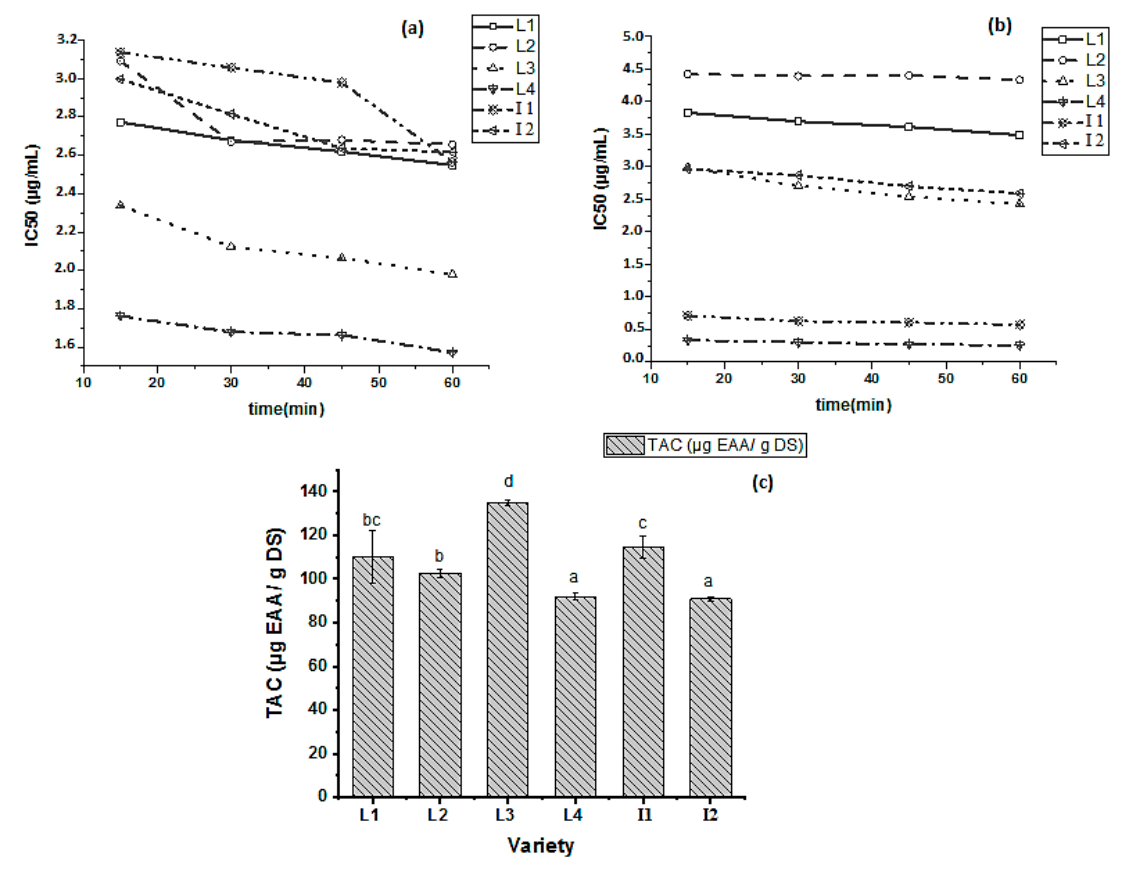
Figure 4. Antioxidant capacity of L1, L2, L3, L4, I1, and I2 varieties by DPPH • method (expressed as IC 50 μ g/mL) ( a ), ABTS •+ method (expressed as IC 50 μ g/mL) ( b ), and total antioxidant capacity (TAC) method (expressed as μ g eq ascorbic acid/g dry sample) ( c ). Table 7. Correlation matrix between phenolics contents and antioxidant activity of pomegranate varieties rinds.